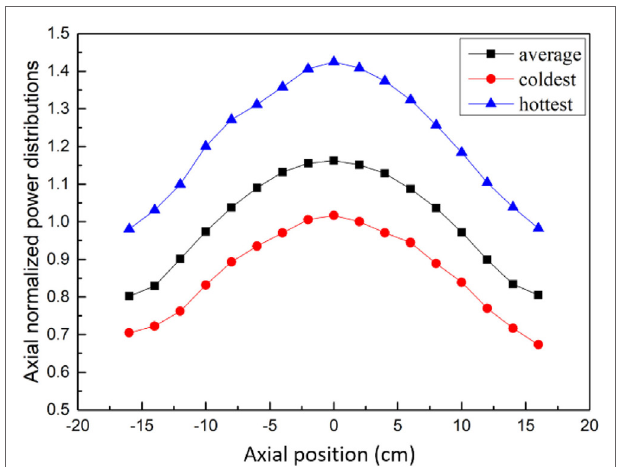
FigUre 6 | Axial normalized power